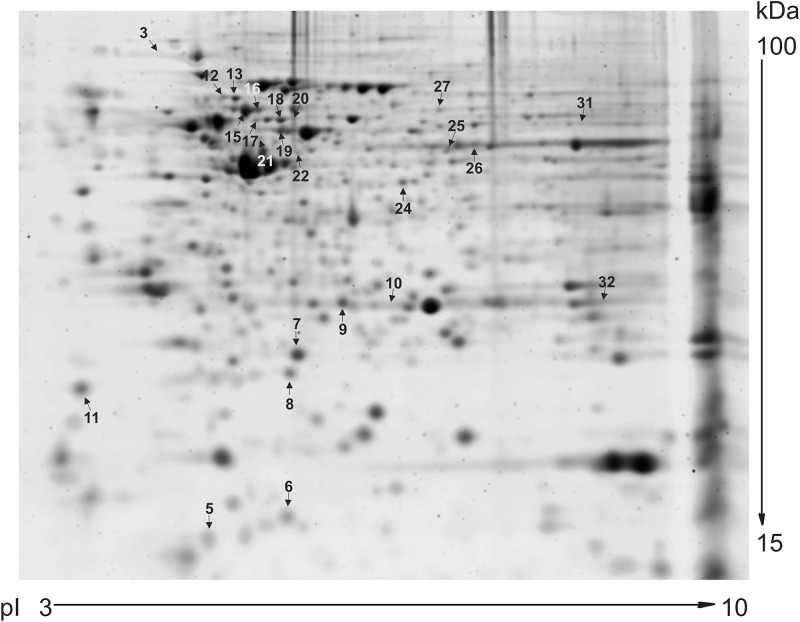
Preparative 2D gel. A total of 100 μg proteins from each sample of LCMV-infected and mock-infected HeLa cells were resolved by 2D PAGE. The protein spots were visualized by SYPRO Ruby Protein Gel Stain. This preparative 2D-gel was used to cut out protein spots that were differentially abundant in analytical gels. Arrows indicate the isolated and identified protein spots with at least 1.5-fold up-regulation or down-regulation. Spots are numbered according to Table 1.